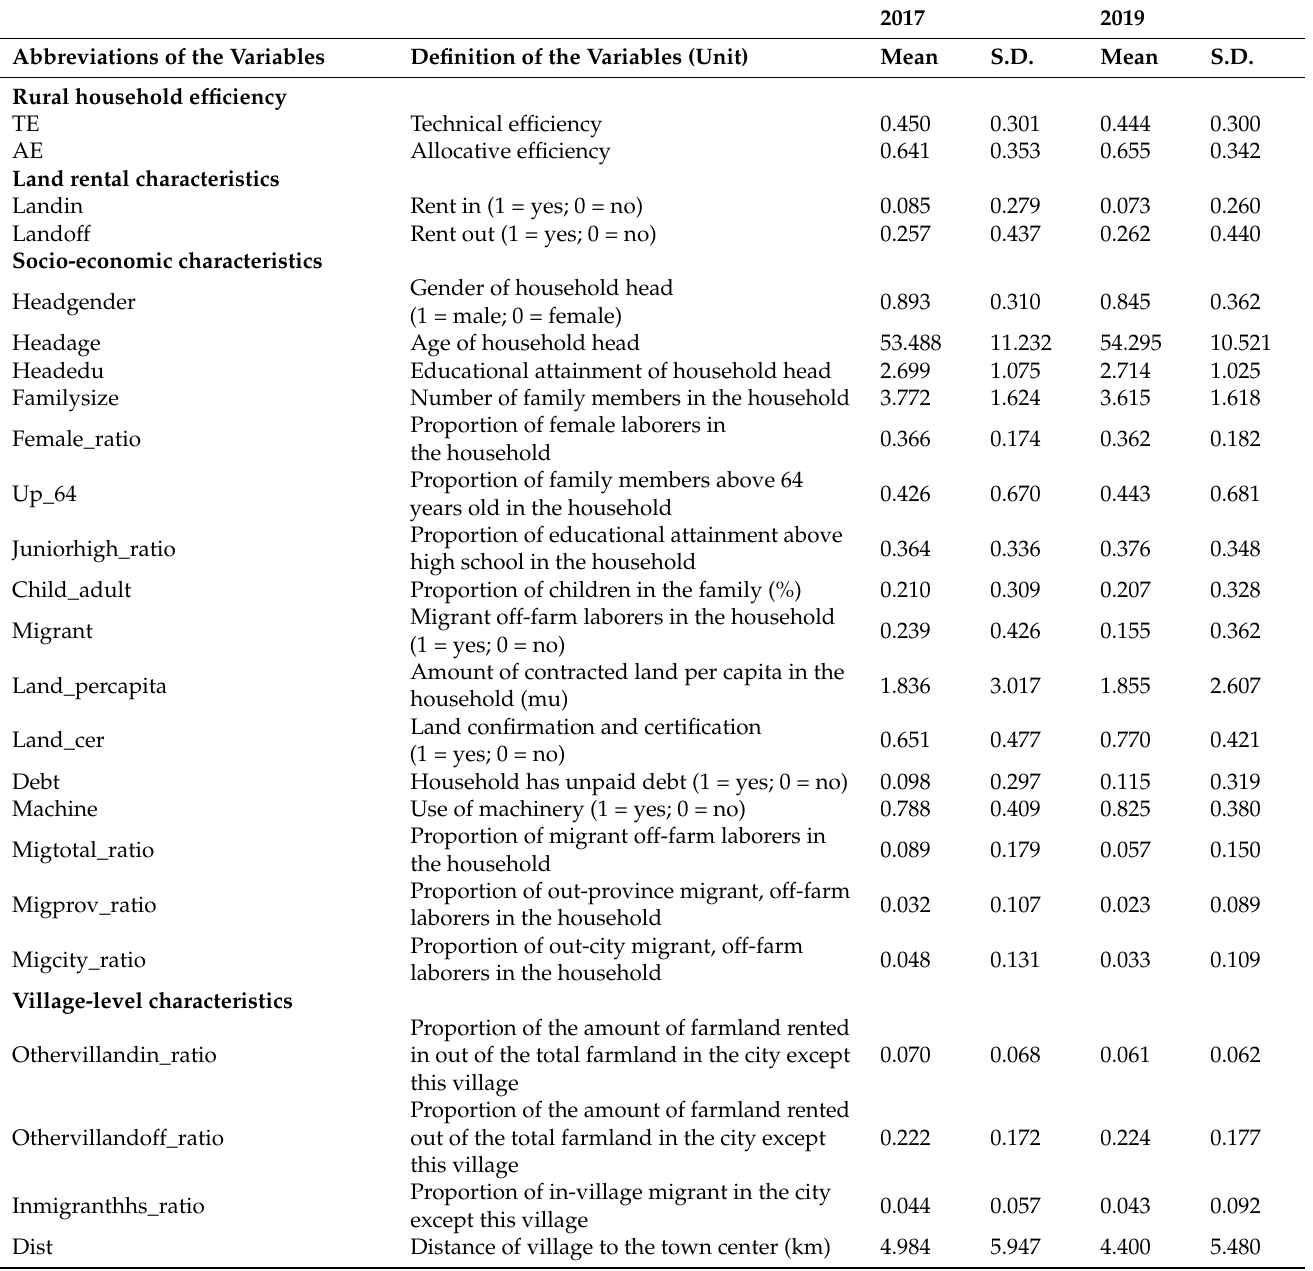
Table 4. Variable selection and summary